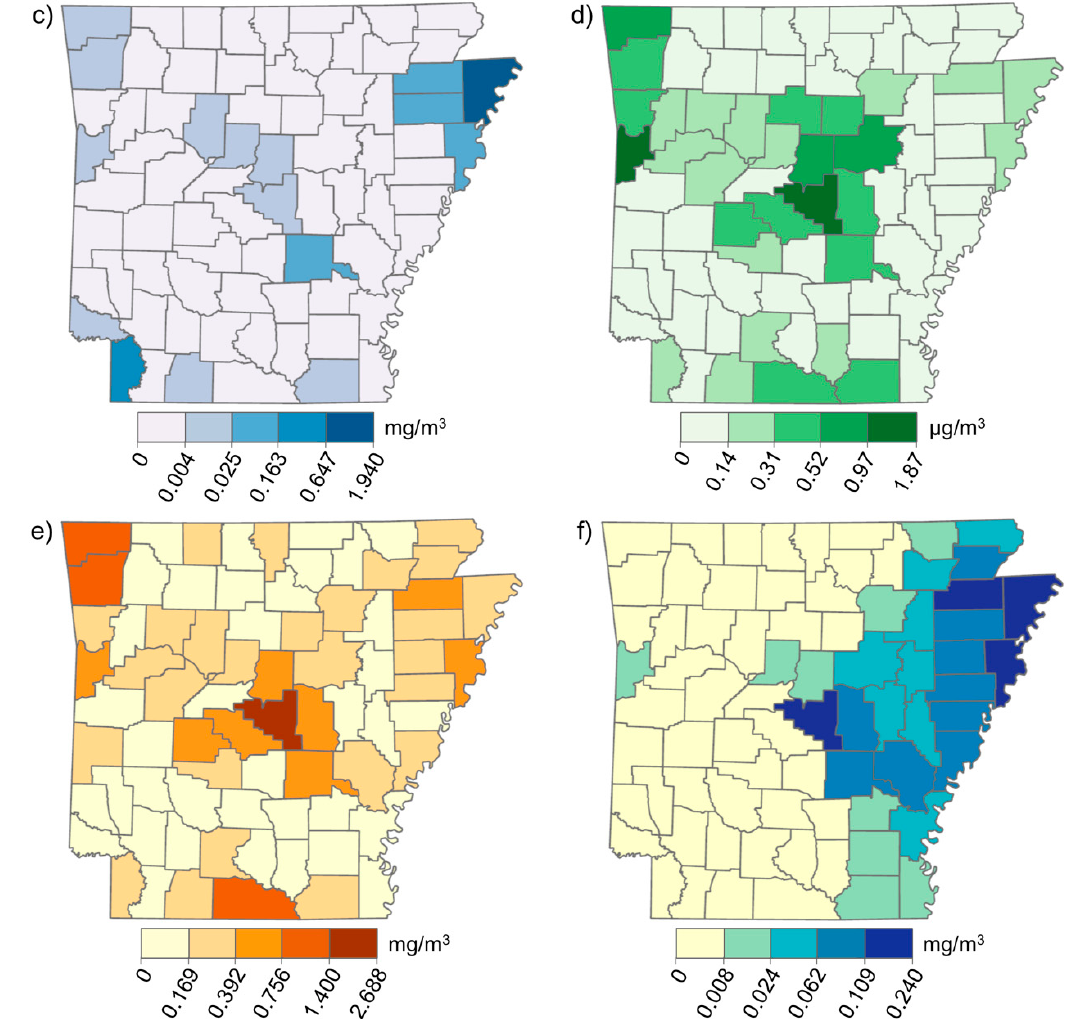
Figure 3. Distributions of selected chemicals’ ambient air concentrations by county in AR: ( a ) 2,4-D, salts and esters; ( b ) carbon tetrachloride; ( c ) carbon disulfide; ( d ) ethylene dibromide; ( e ) methyl bromide; and ( f ) trifluralin.